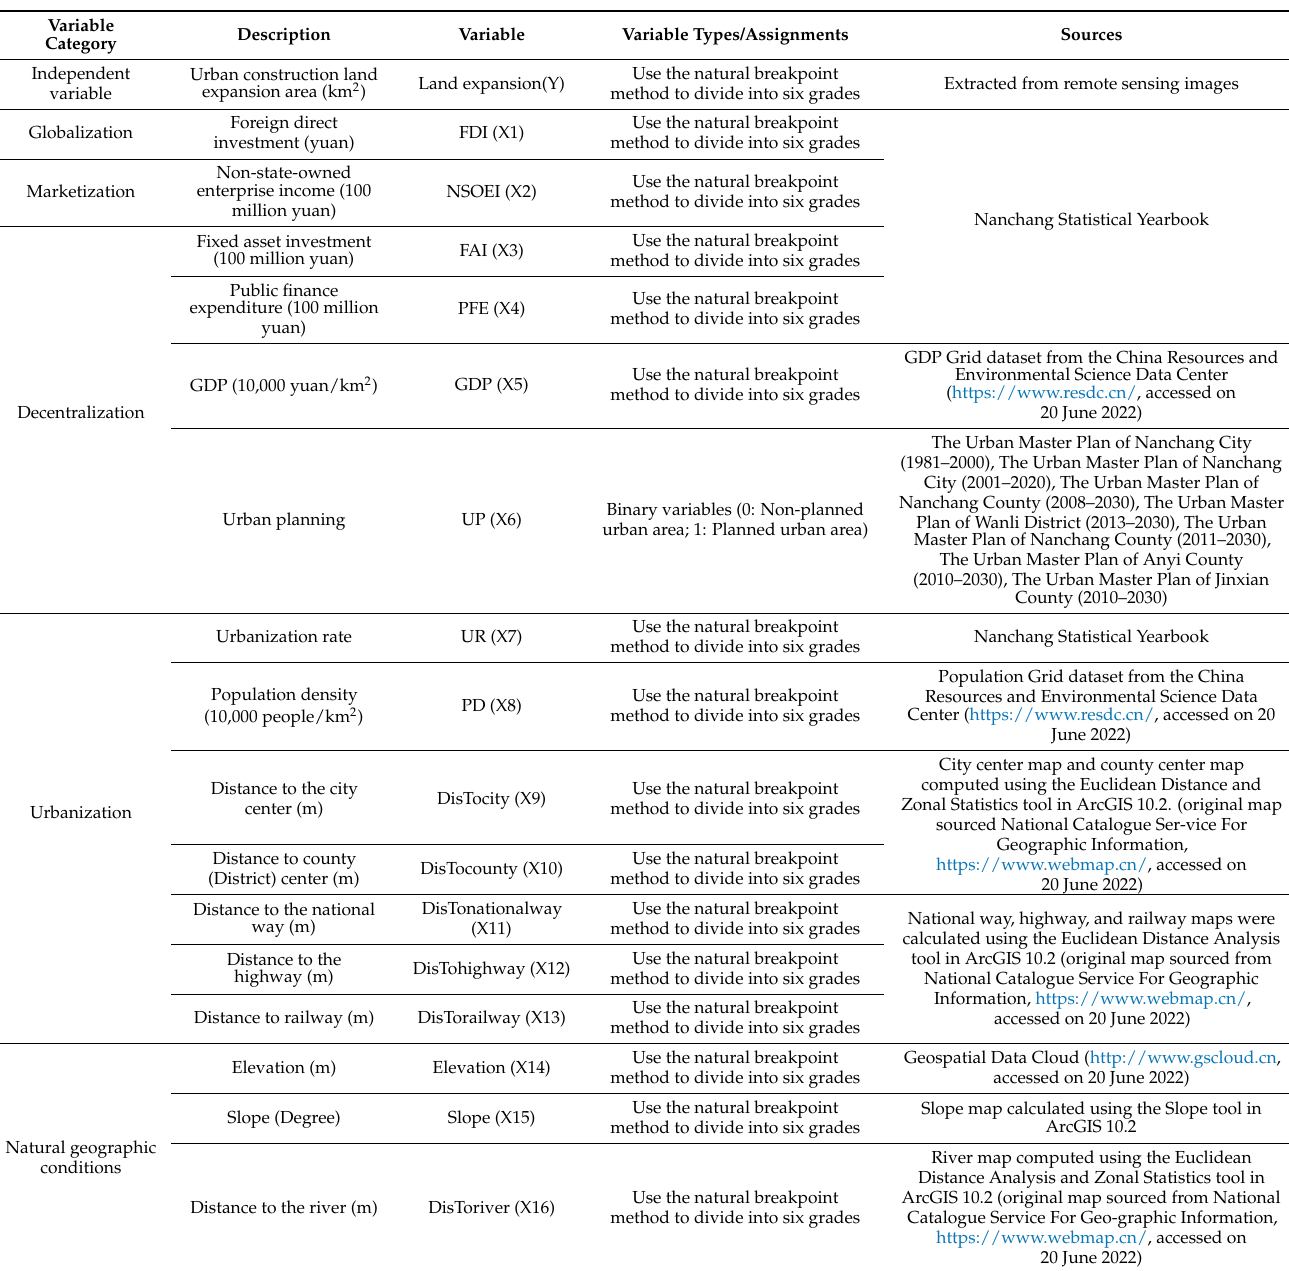
Table 1. Selected Variables that study the influencing factors of urban